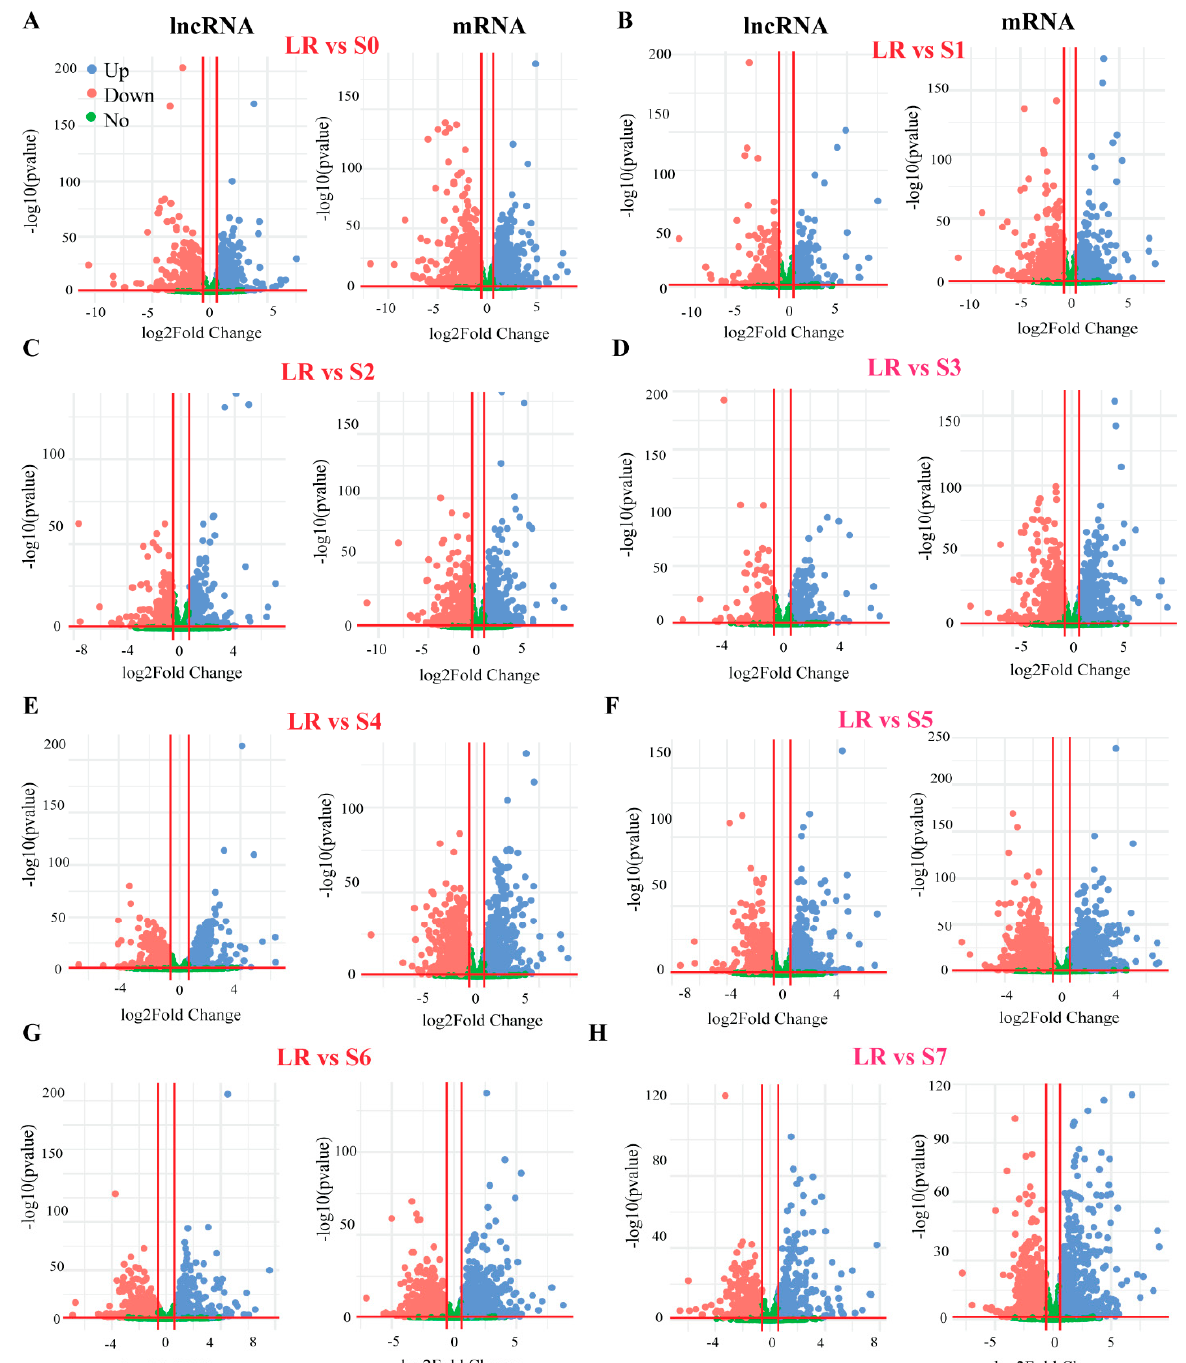
Figure 2. Volcano plots of differential expression (DE) analysis of white lupin roots under P defi- ciency. ( A ) DE genes of LR vs. S0, ( B ) LR vs. S1, ( C ) LR vs. S2, ( D ) LR vs. S3, ( E ) LR vs. S4, ( F ) LR vs. S5, ( G ) LR vs. S6, and ( H ) LR vs. S7. The left side of each panel represents lncRNA and the right side represent mRNA genes. The blue and red dot represent up and downregulation, respectively. LR, lateral root; S0–S7, different developmental stages of white lupin roots.